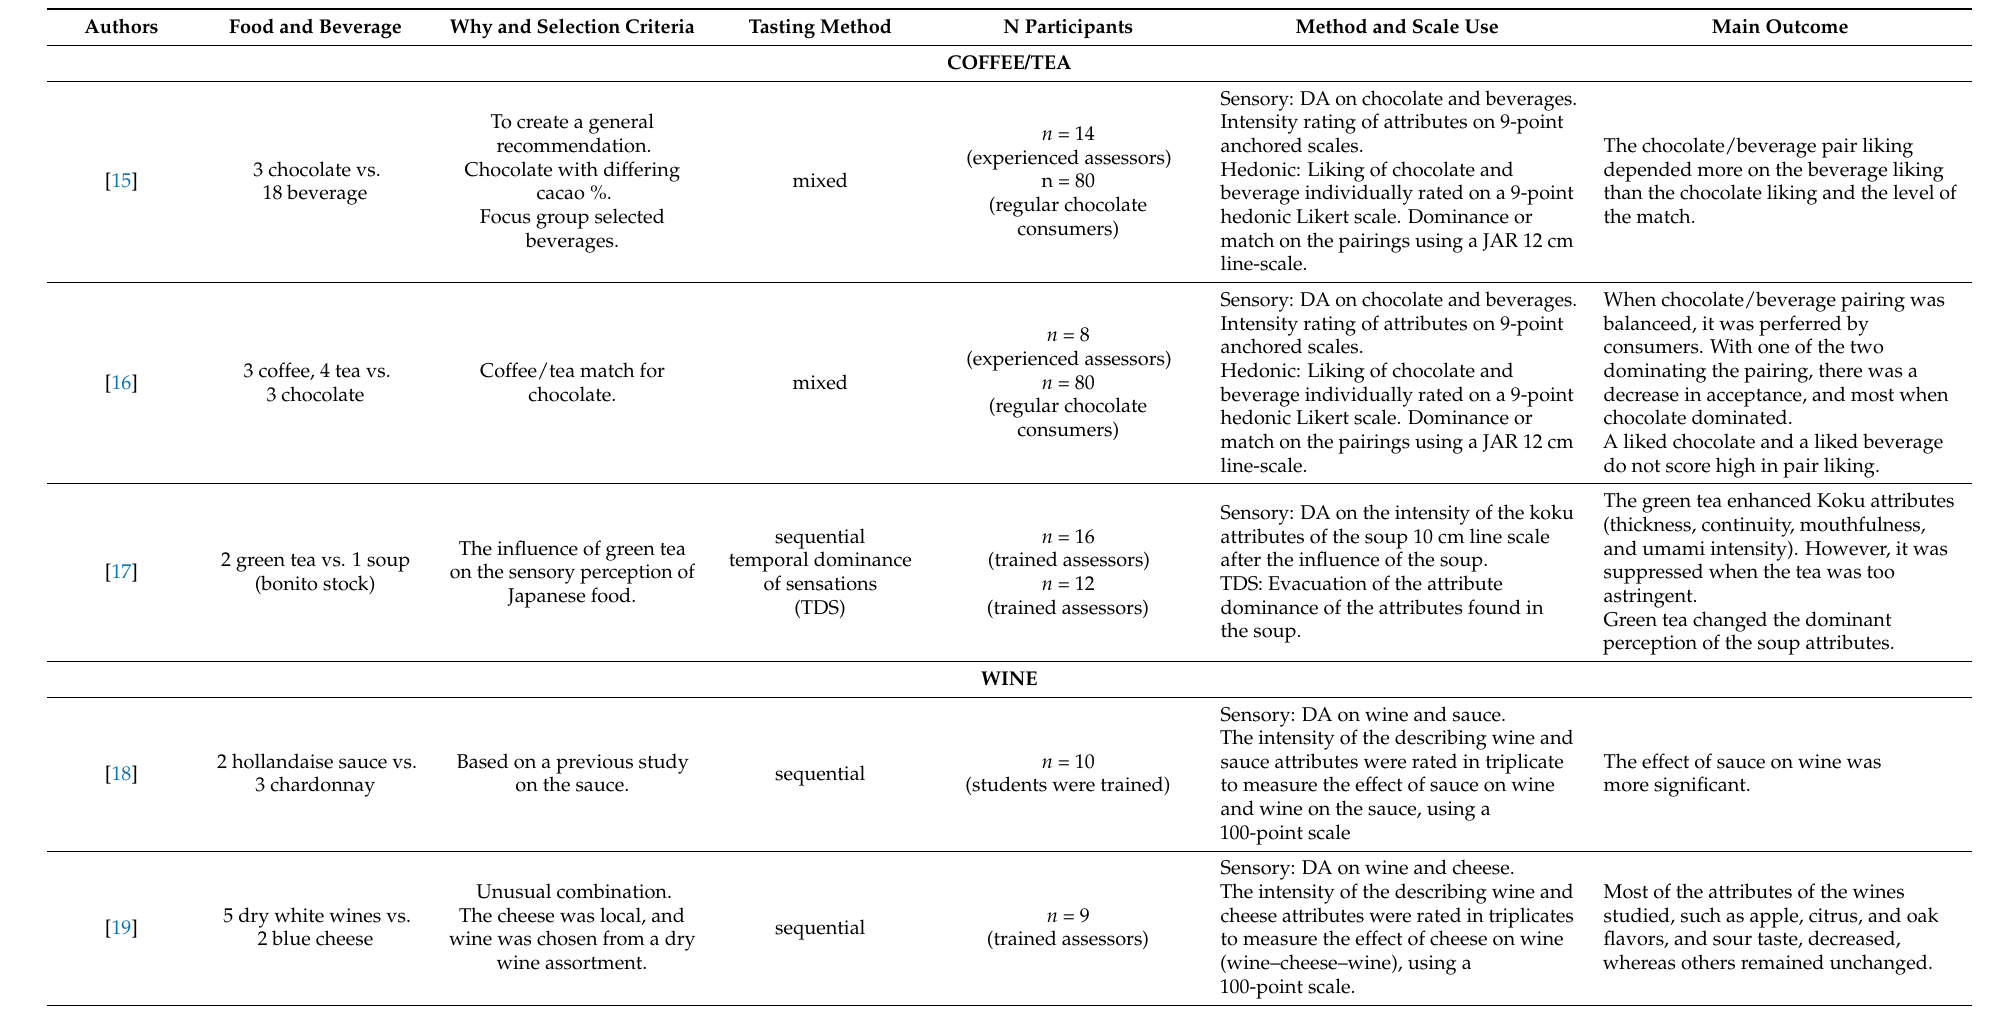
Table 2. Characteristics for the included